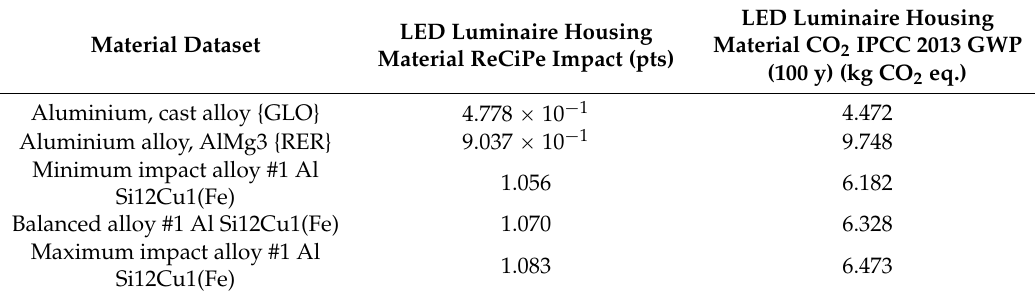
Table 10. Environmental impact of the material of a LED luminaire housing.